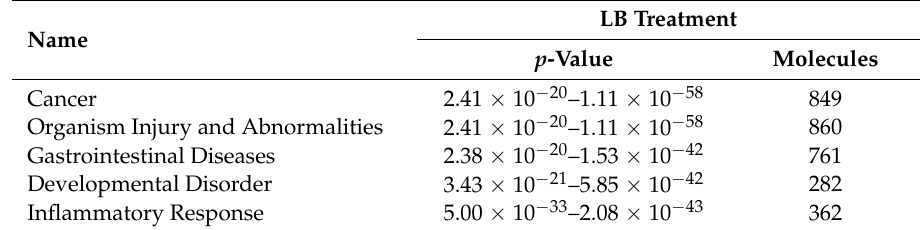
Table 8. Top gene Diseases and Bio Function associated with lactobacilli treatment—IPA analysis.